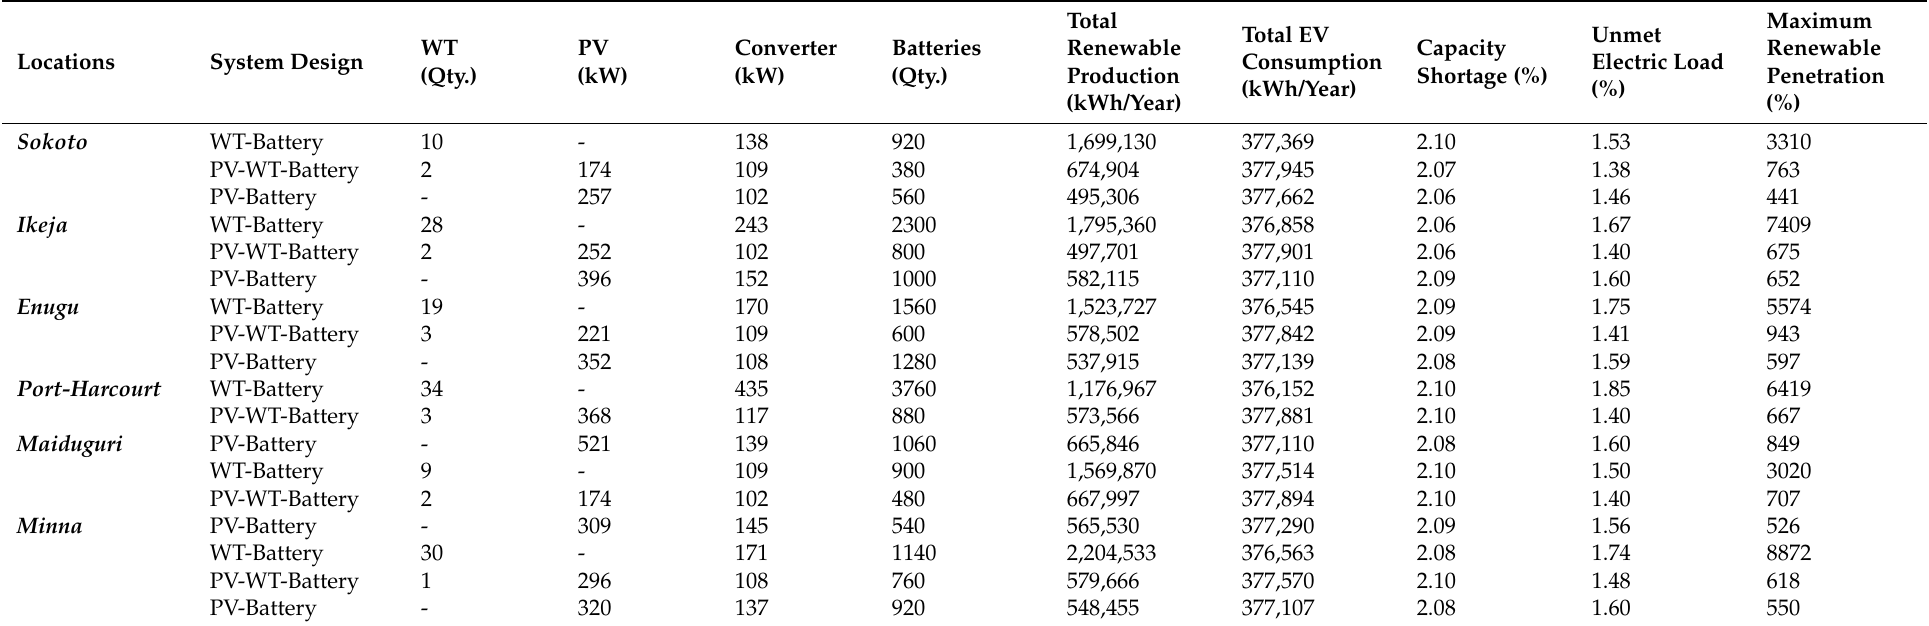
Table 14. Optimal sizes and technical performance results of the optimized systems for the EV charging